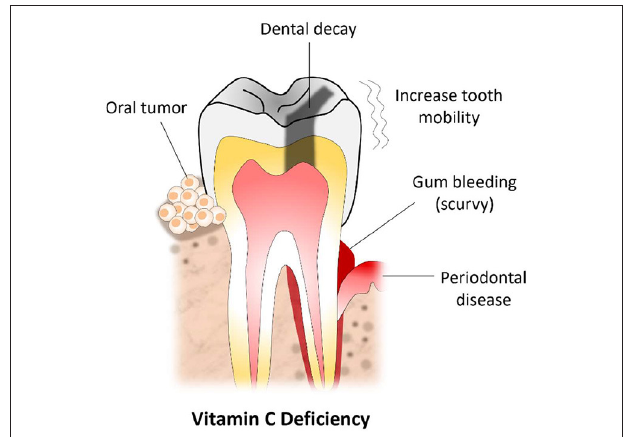
FIGURE 2 | Vitamin C deficiency and commonly encountered oral